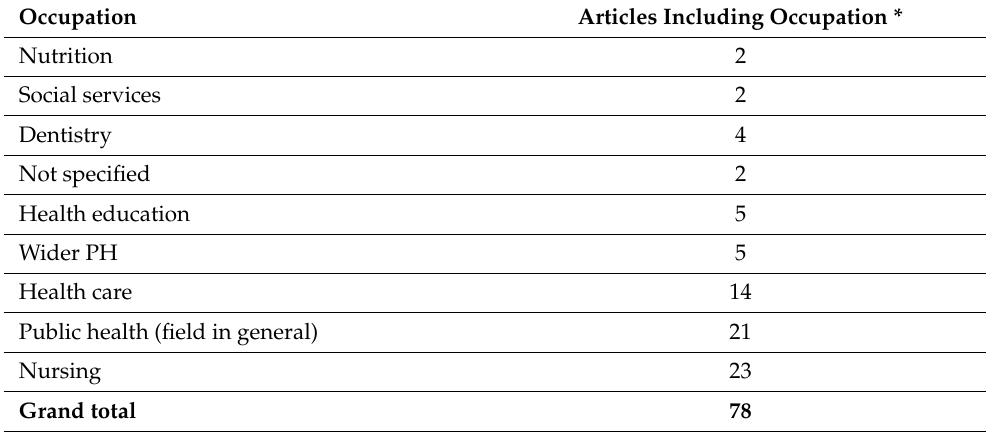
Table 1. Occupations included within